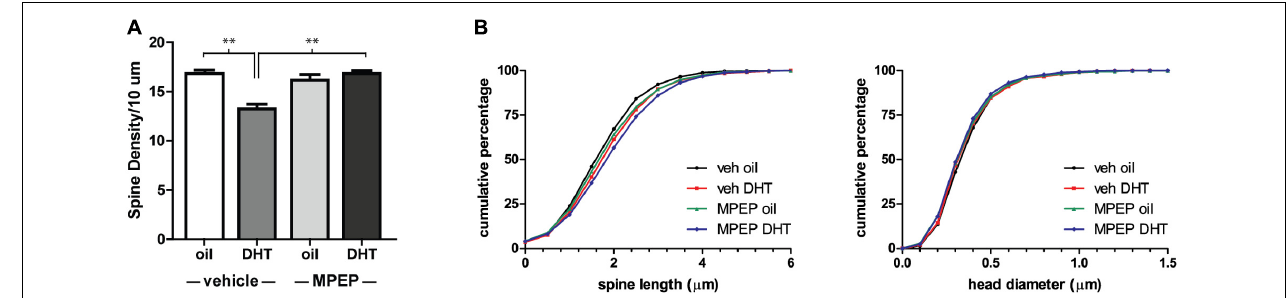
FIGURE 4 | DHT-induced spine plasticity is dependent on mGluR5. Spine density and morphology were measured in castrated male rats receiving veh/MPEP (1 mg/kg) 30 min prior to injection of oil/DHT (1.5 mg). (A) Average spine density per 10 µ m of MSNs in the NAcSh 24 h after hormone treatment. (B) Spine morphology of MSNs in the NAcSh 24 h after hormone treatment as assessed by binned cumulative probability distributions of spine length and head diameter. n = 4–5 animals per group with spine density averaged from 6 to 9 dendritic segments per animal, ∗∗ p < 0.001.